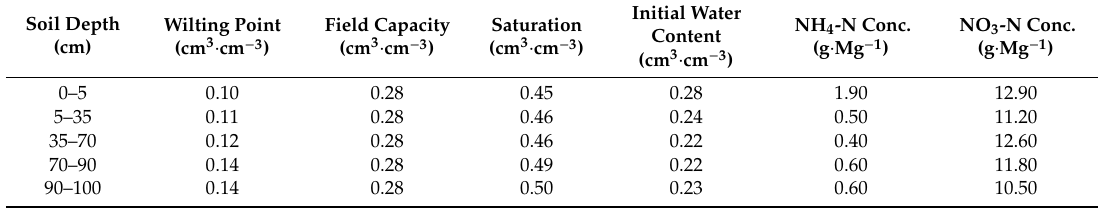
Table 3. Initial conditions of soil profile and physical characteristics in the field,